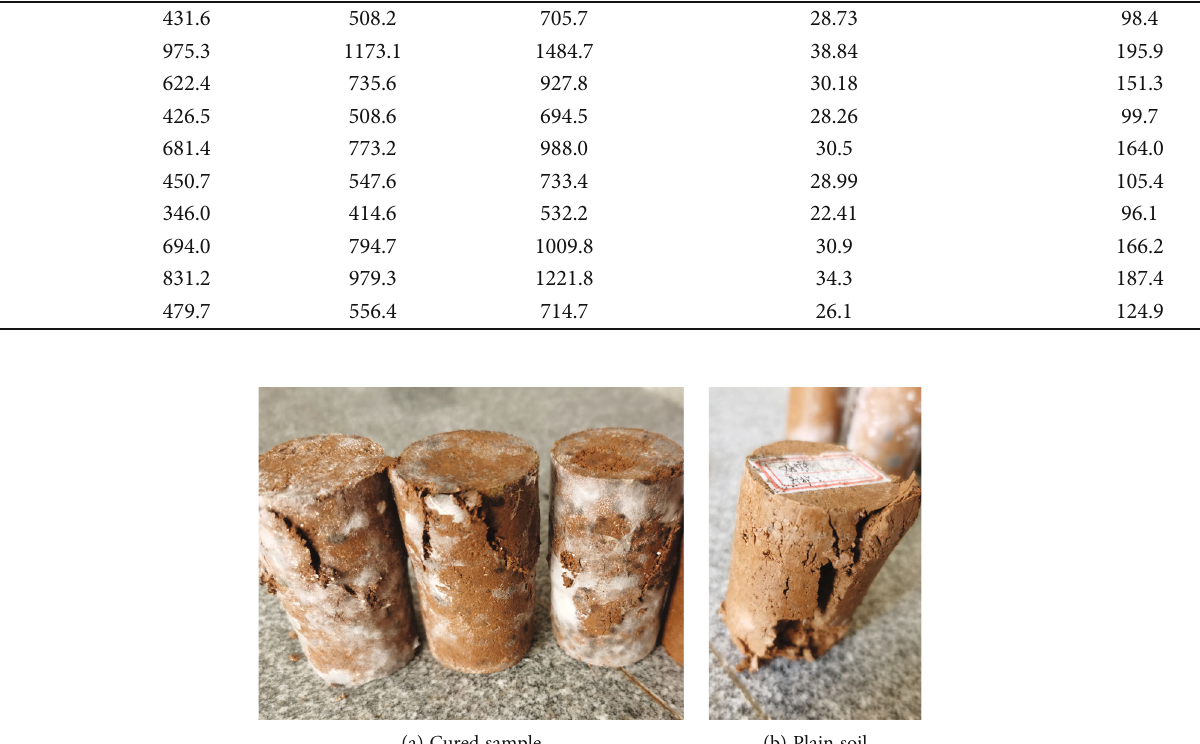
Table 4: Deviatoric stress values and strength indices of specimens under di ff erent con fi ning pressures. Sample